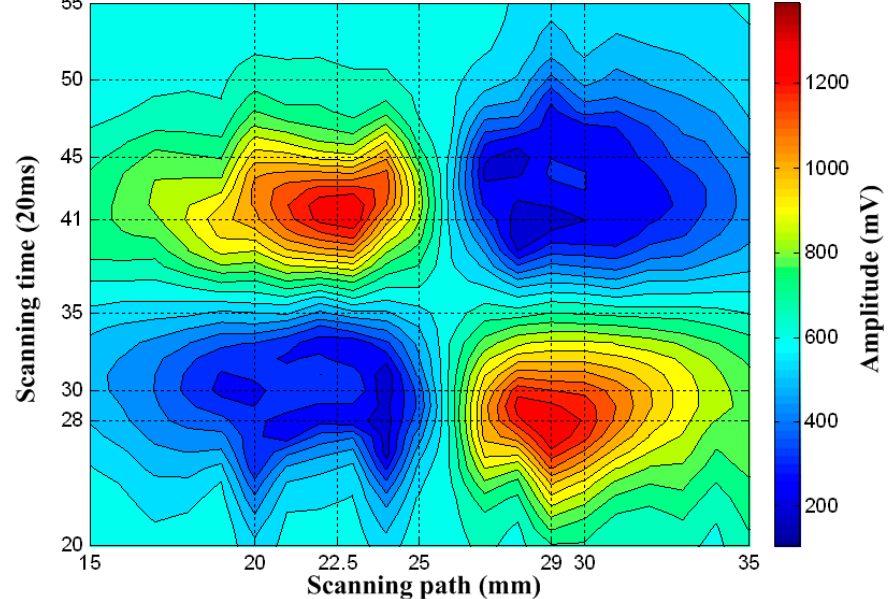
Figure 8. C-scan outline images of defect 1 in the direction of magnetic flux.